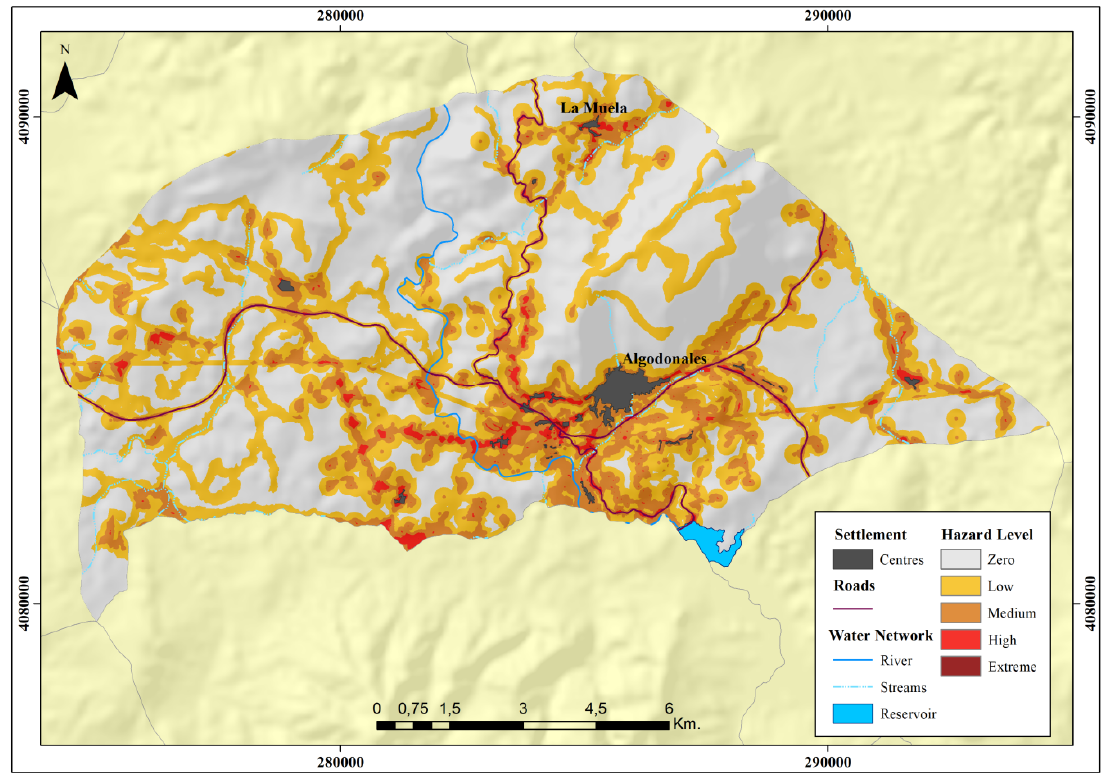
Figure 8. Induced hazard map.